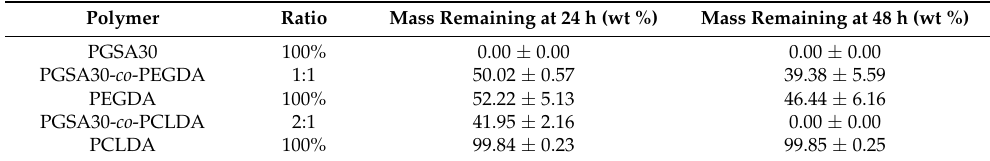
Table 3. DLP-AM printed PGSA30, PGSA30- co -PEGDA, PEGDA, PGSA30- co -PCLDA, and PCLDA degraded in 0.1 M of NaOH at 37 °C .